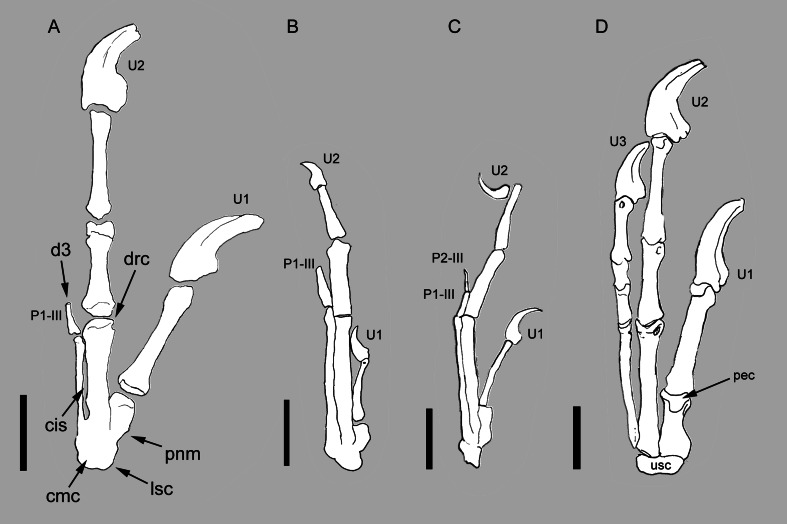
Comparison between the manus of Balaur and other paravians.Comparison of the manus of (A) Balaur to those of (B) the enantiornithine Zhouornis; (C) the pygostylian Sapeornis; and (D) the dromaeosaurid Deinonychus, showing bird-like features of Balaur. (A) after Csiki et al.. (2010, Fig. 1, mirrored from original); (B) after Zhang et al. (2013, Fig. 7); (C) after Zhou & Zhang (2003, Fig. 7); (D) after Wagner & Gauthier (1999, Fig. 2). All drawn at the same metacarpal II length. Scale bar: 20 mm (A, D); 10 mm (B, C). Abbreviations: cis, closed intermetacarpal space; cmc, carpometacarpus; d3, reduced third digit; drc, distally restricted condyles; lsc, laterally shifted semilunate carpal; p1-III, first phalanx of manual digit 3; p2-III, second phalanx of manual digit 3; pec, proximally expanded extensor surface; pnm, proximally narrow metacarpal I; U, ungual; usc, unfused semilunate carpal.